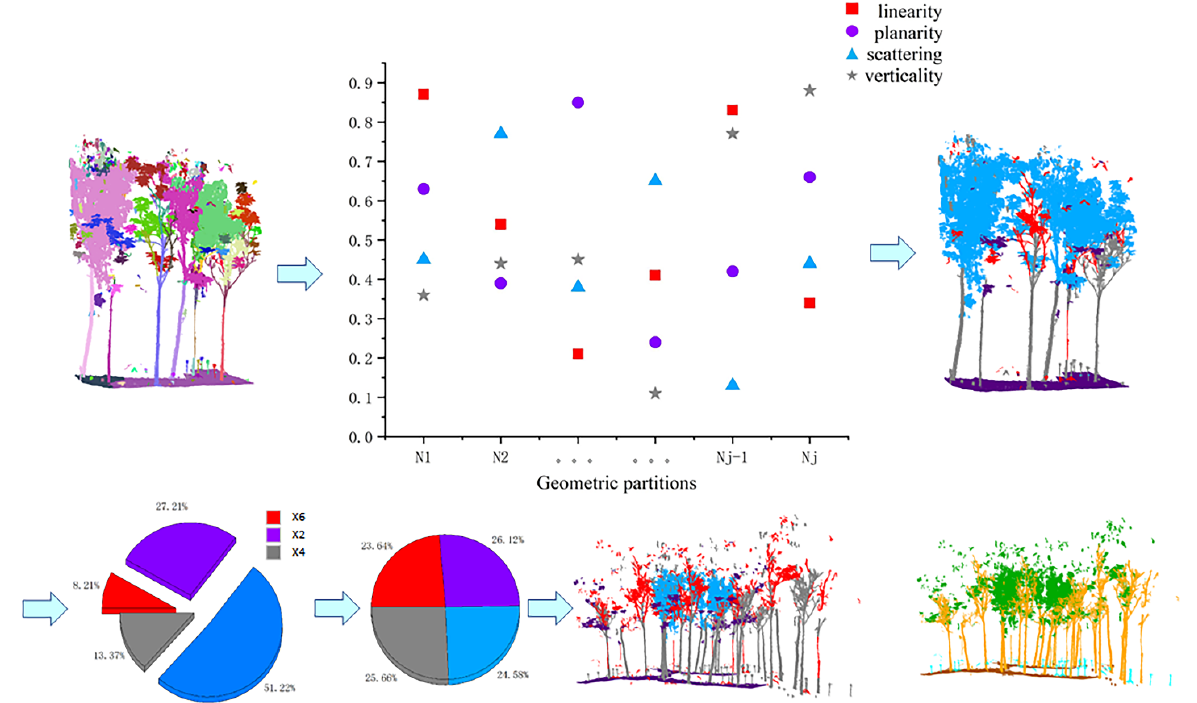
Figure 7. Using Figure 5a as an example, the main geometric features selected for each geometric partition are visualized.